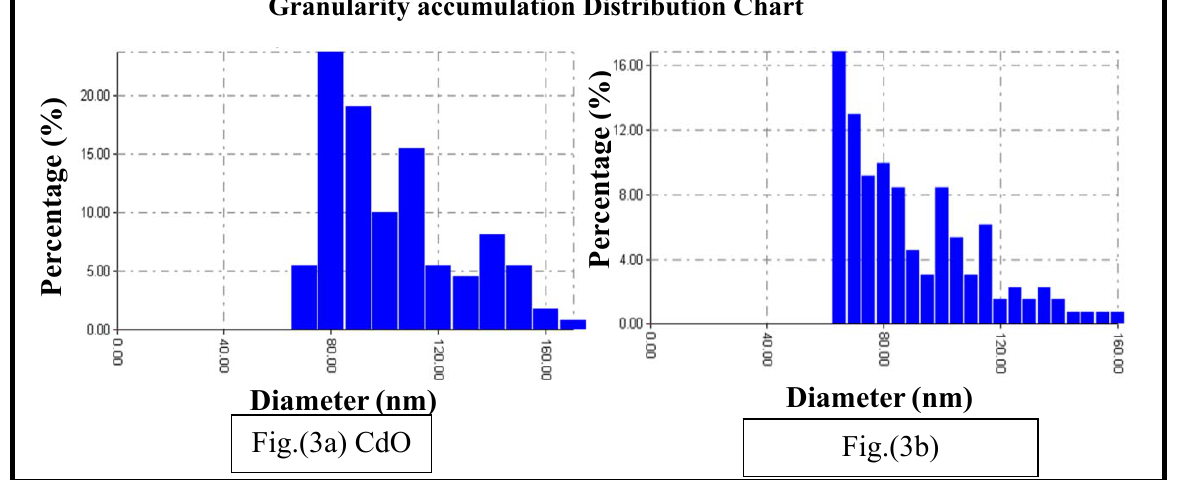
Fig.3a, b: AFM grain analysis report for the CdO and CdO